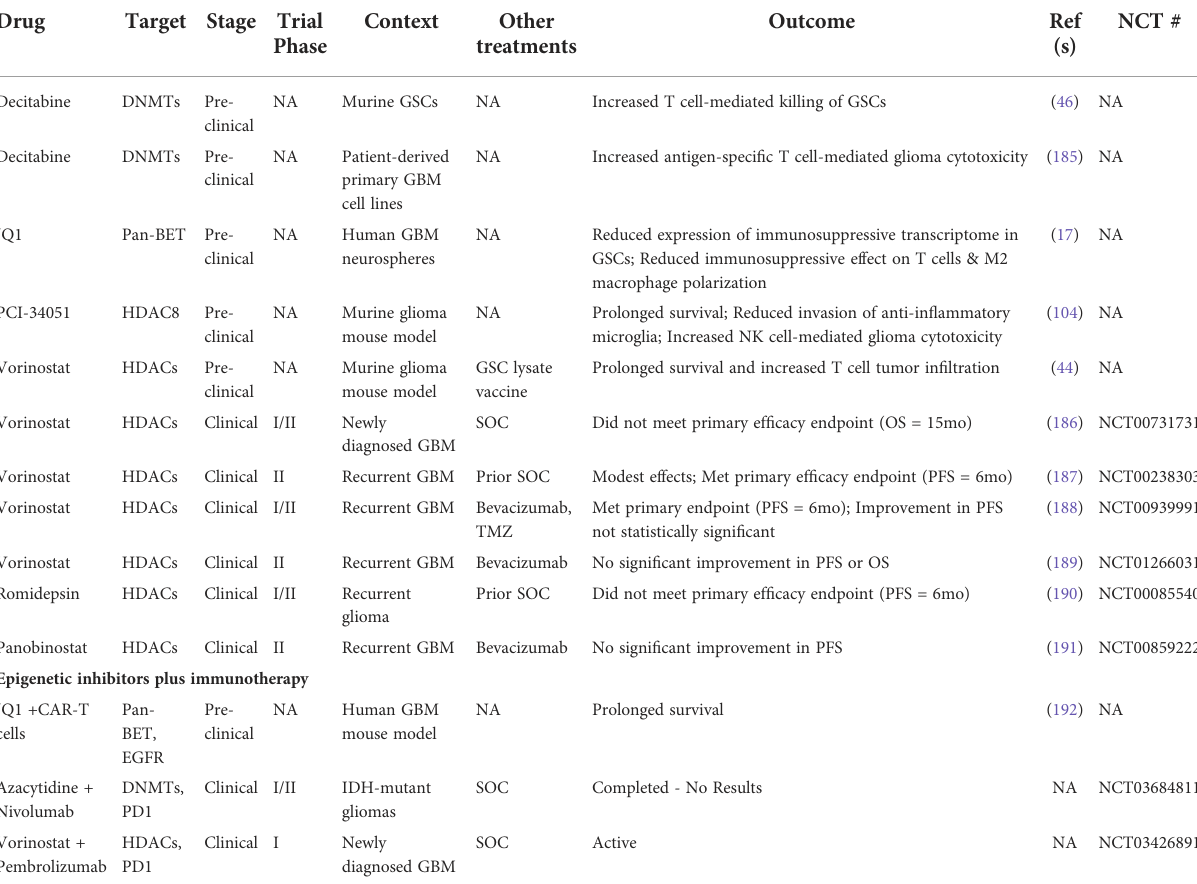
TABLE 3 Epigenetic- and immunotherapy-based attempts to target GSCs. Epigenetic